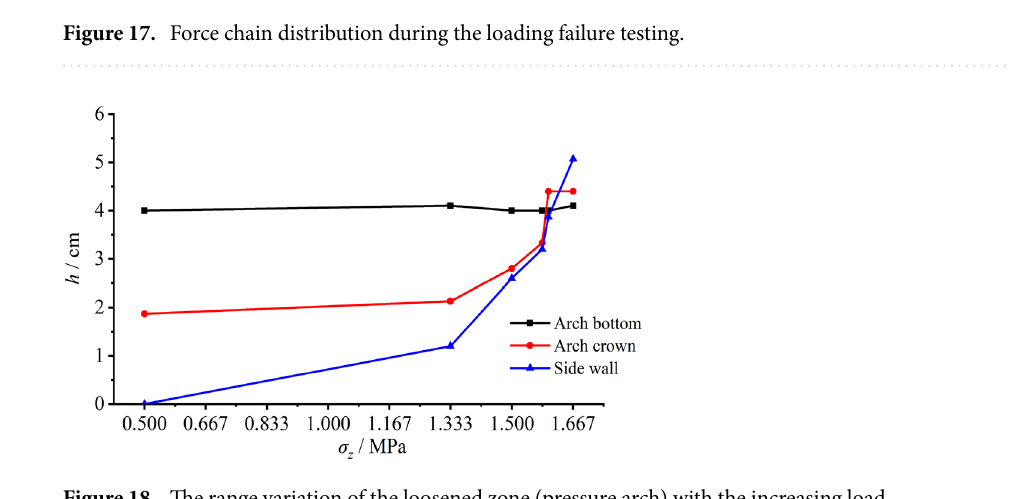
and fell afterwards. The stress at E9 got the maximum value at σ z = 1.55 MPa and σ θ = 2.10 MPa. The maximum